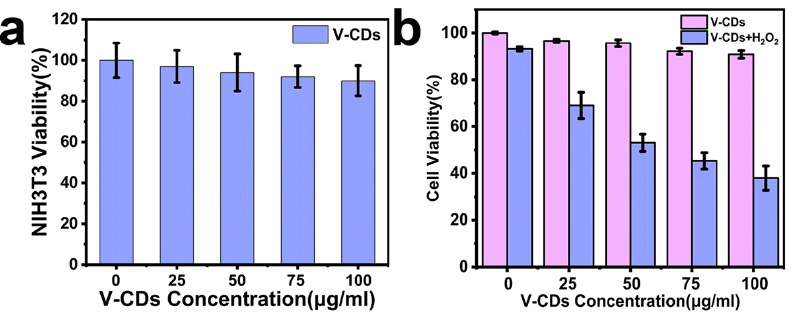
Figure 5. ( a ) The viability NIH3T3 cells incubated with various concentrations of V − CDs. ( b ) The viability HeLa cells incubated with various concentrations of V − CDs in the presence of H 2 O 2 .